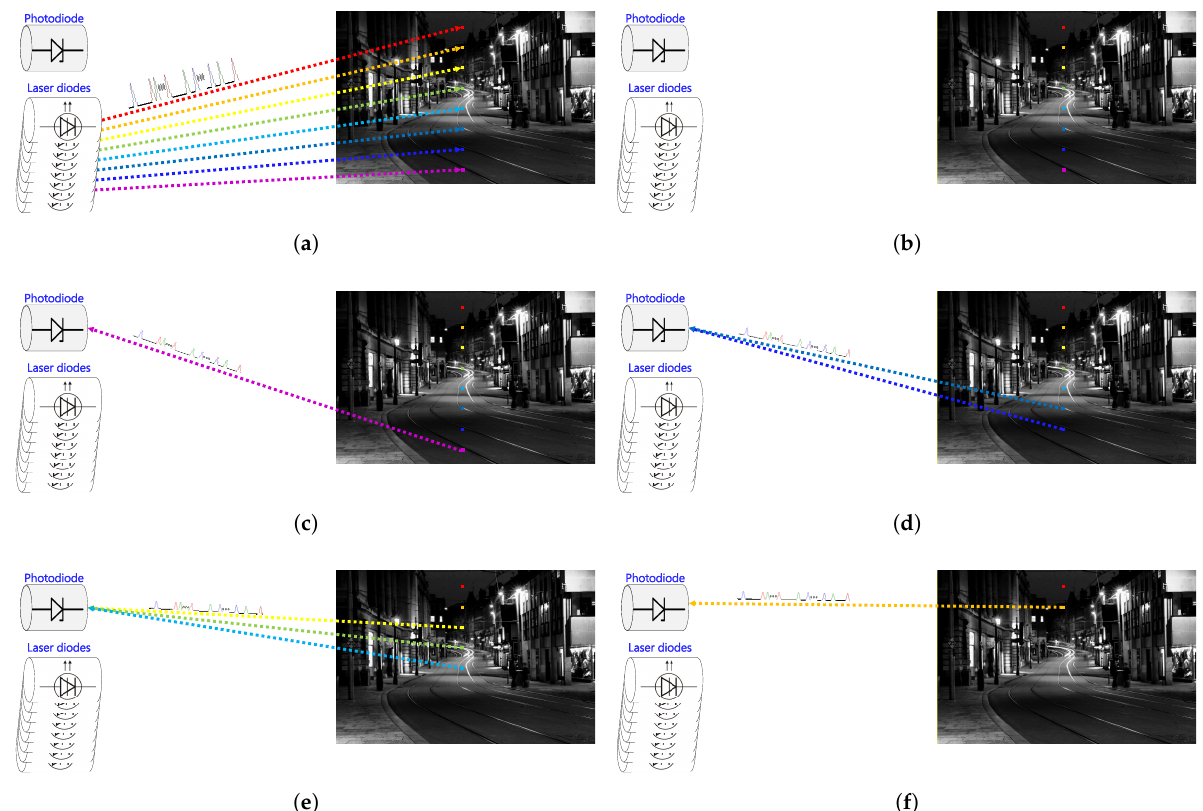
Figure 8. Operating strategy of the concurrent firing LIDAR scanner with coded pulses. ( a ) The LIDAR fires all coded pulse streams to each target, all at once; ( b ) The LIDAR waits for the reflection of the laser; ( c ) after reception, the LIDAR decodes the received pulse stream and then calculates the target distance with the identifier at the received pulse stream. ( d – f ) The LIDAR repeats ( c ) the sequence for all targets. After all is finished, the LIDAR rotates the body to the next angle and restarts from ( a